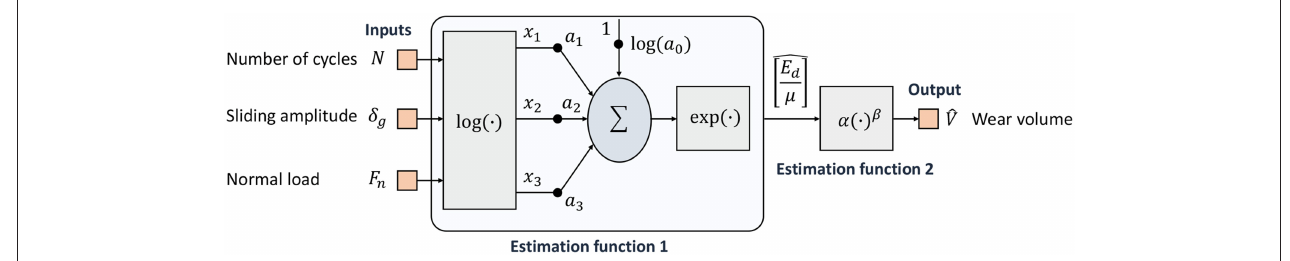
FIGURE 5 | Schematic of the ANN-based semi-physical fretting wear model (Haviez et al., 2015).